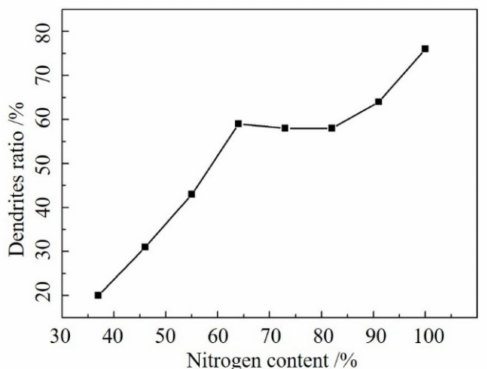
Figure 6. The relationship between the dendrite area fraction (in the cross section) and the nitrogen content of the nitrogen–argon gas atmosphere. When the nitrogen content of the nitrogen–argon atmosphere was less than 37%, the hardness curves were not plotted because the depth of the dendrites was less than 0.3 mm, and the microhardness was